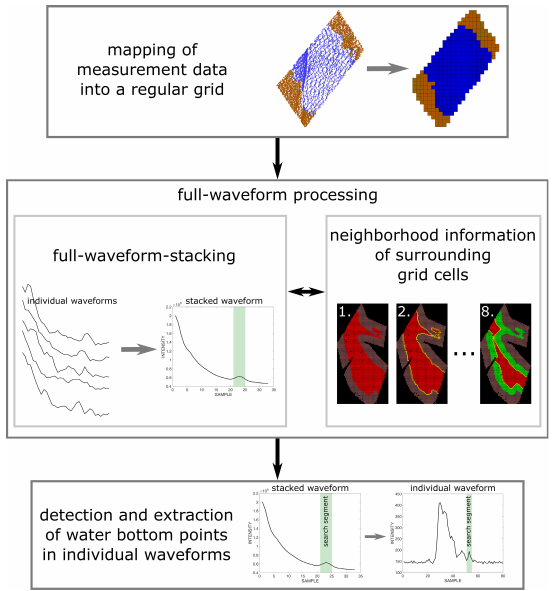
Figure 5. Workflow of extended processing of full-waveform data.